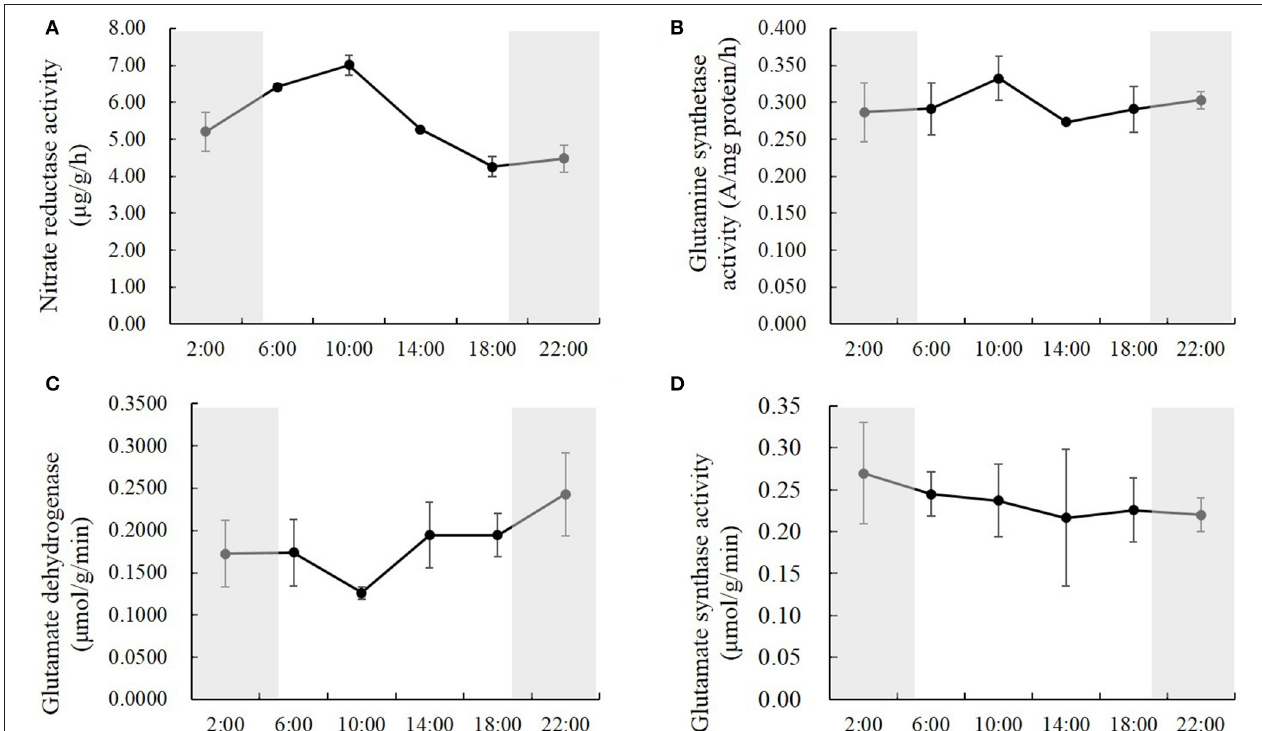
FIGURE 3 | The activities of nitrate reductase (A), glutamine synthetase (B), glutamate dehydrogenase (C), and glutamate synthase (D) in the rice shoots at the time of 2:00, 6:00, 10:00, 14:00, 18:00, and 22:00. Values are mean ± SD from three biological replicates.